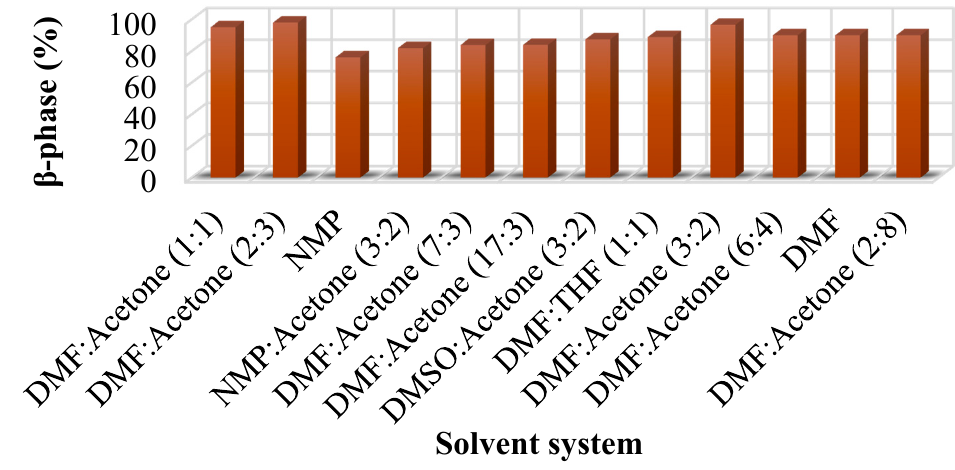
Figure 9. Various solvent systems used for PVDF-based PEMs and fraction of β -phase obtained [18,27,30,42,46,49,70,78,79,82–89].